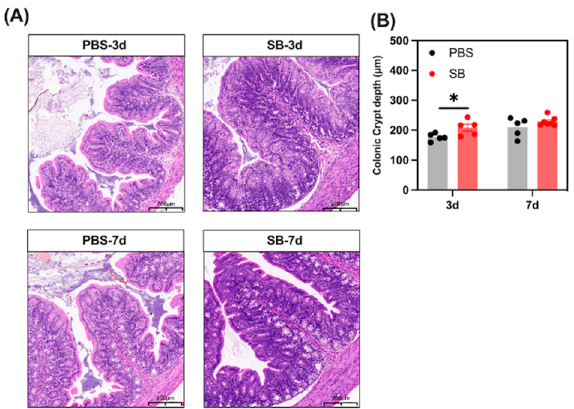
Figure 7. Effects of S. boulardii early intervention on the gut morphology integrity. ( A ) Representative images of HE-stained colon tissues (scale bars, 200 μ m). ( B ) Statistical analysis of crypt depth. Values are expressed as means ± SEM, n = 5–6. * p < 0.05. d, day. PBS, rats early intervened with phosphate buffer solution. SB, rats early intervened with S. boulardii .